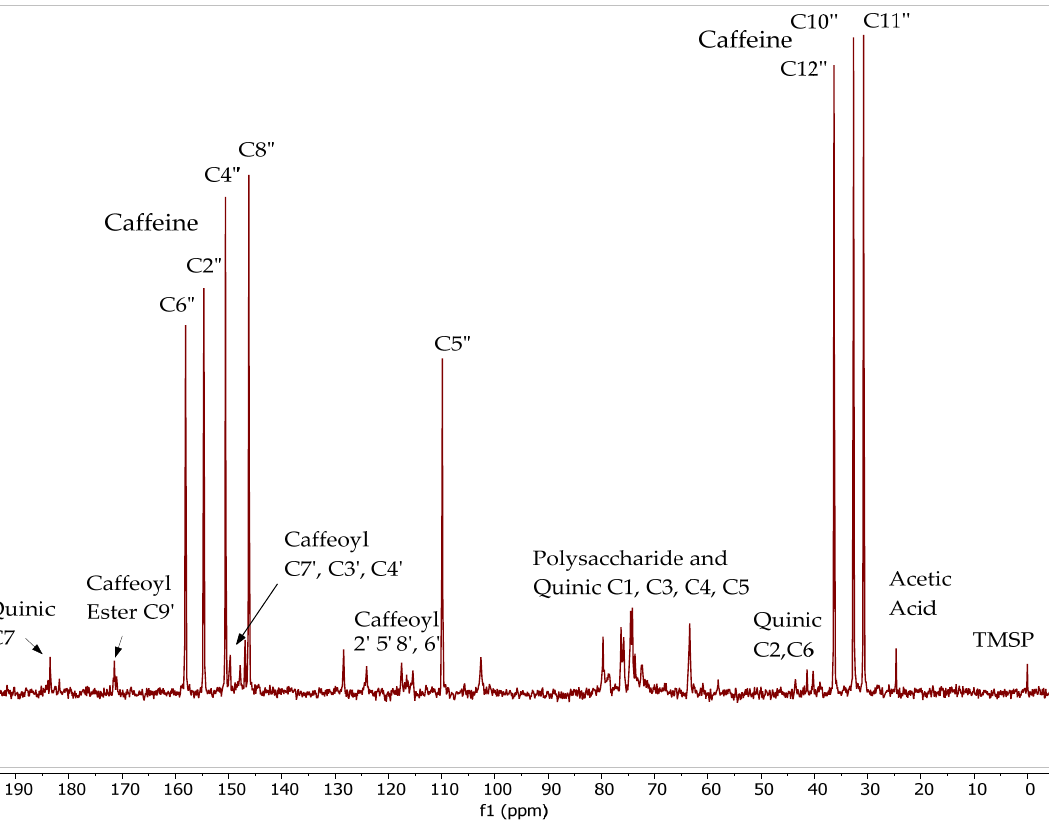
Figure 10. 13 C NMR spectra of CEWCCE in D 2 O operating at 75.44 MHz.